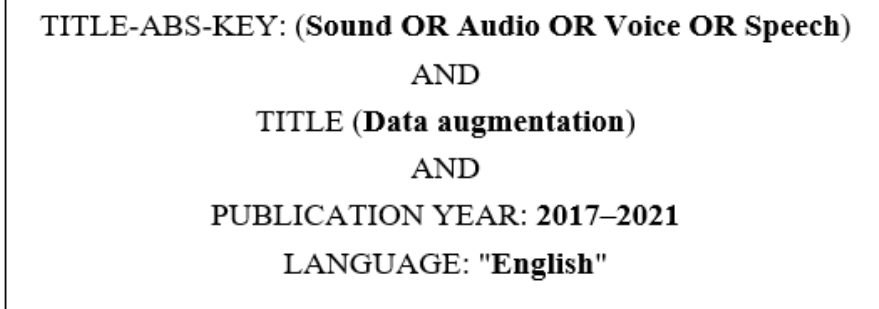
Figure 1. Search query and its parameters